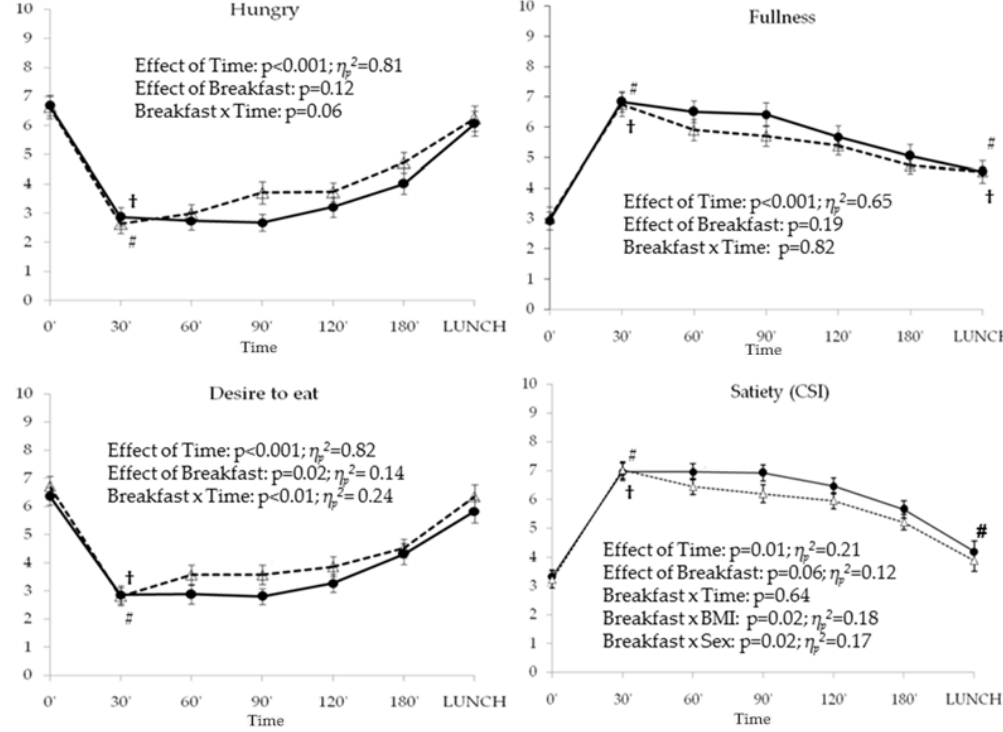
Figure 1. Appetite Ratings (Visual Analog Scale). Average and standard errors for VAS score (cm) after G-Breakfast ( ) and C-Breakfast ( ) at the different time points. The effects of time, breakfast and interactions were calculated by repeated measures ANOVA, except for CSI index that were calculated by repeated measures ANCOVA adjusted by Sex and BMI. # Statistically different means compared to baseline (0 ′ ) after G-Breakfast. † Statistically different compared to baseline (0 ′ ) after C-Breakfast.